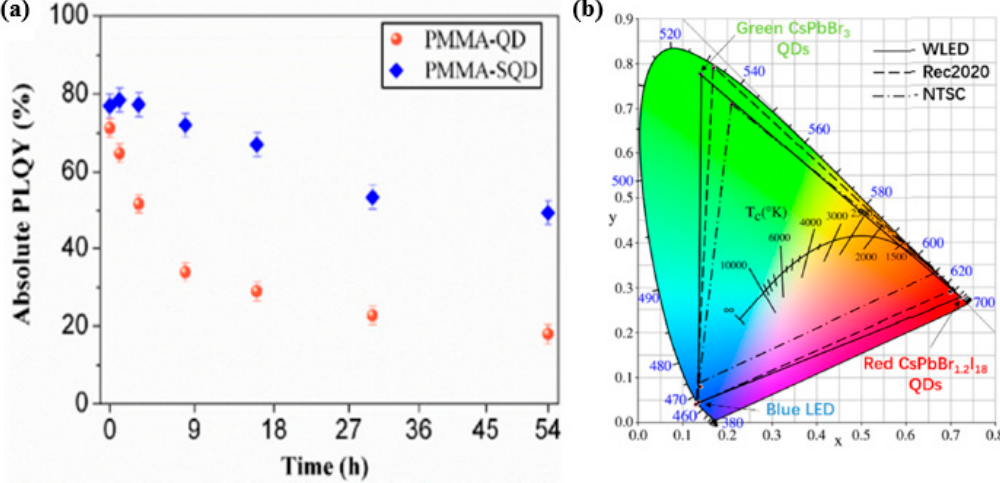
Figure 17. ( a ) The PLQY values under UV irradiation; ( b ) color gamut of the resulting WLED [82]. Figure reproduced with permission from Optical Society of